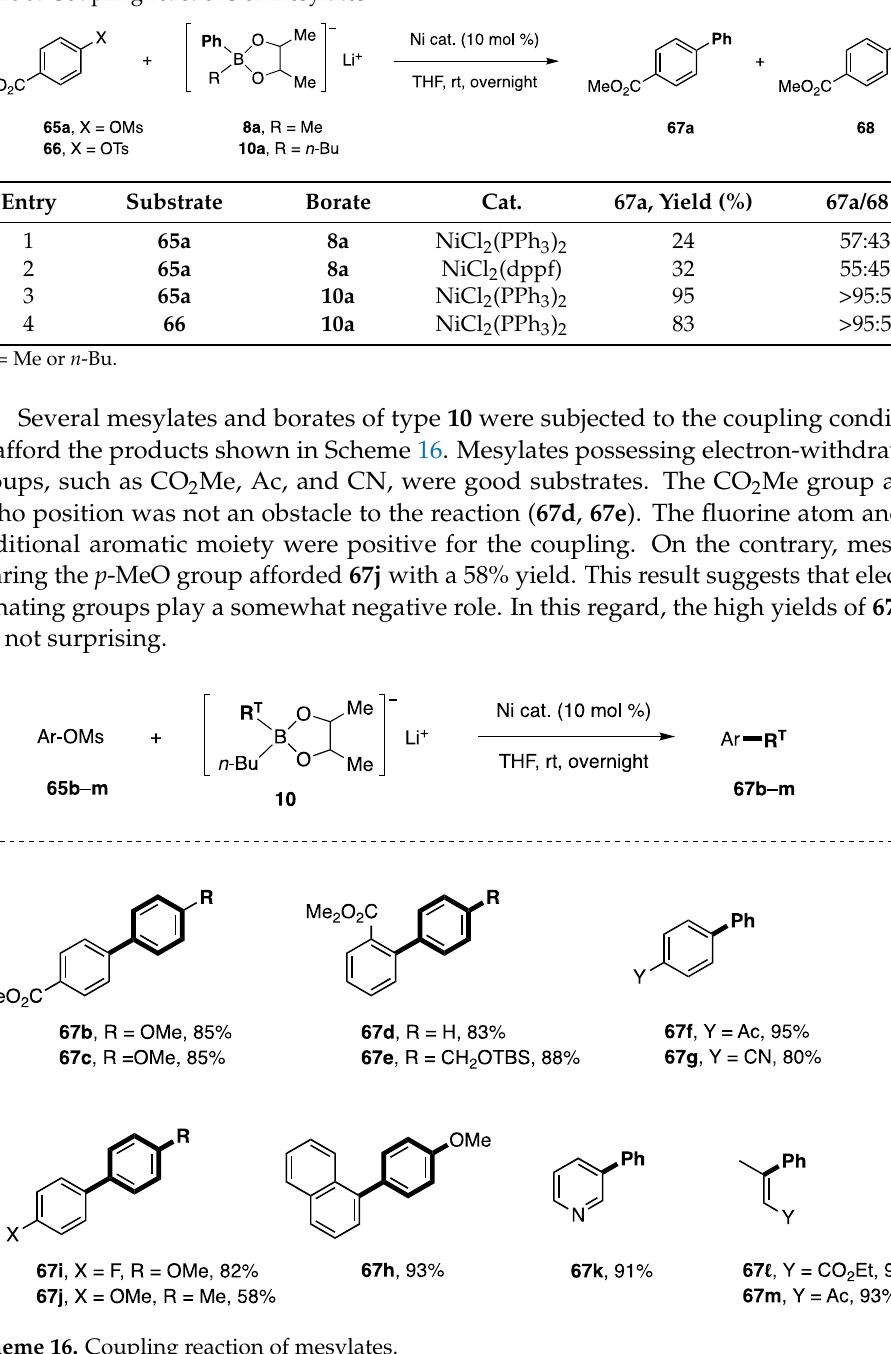
Table 5. Coupling reactions of mesylates.